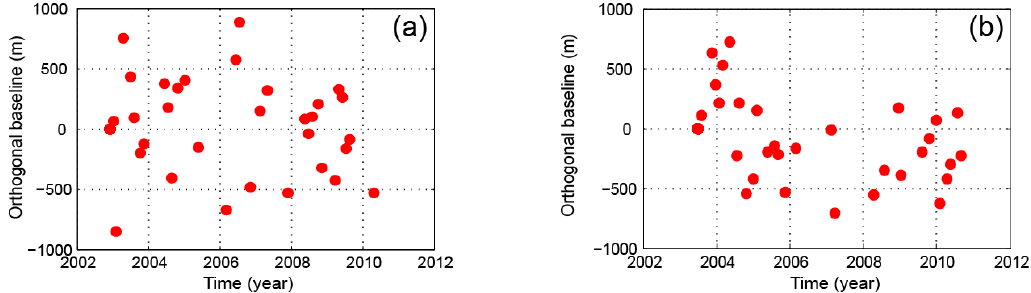
Figure 2. Spatial and temporal distribution of SAR images for the ENVISAT dataset acquired in ascending ( a ) and descending ( b ) geometries.